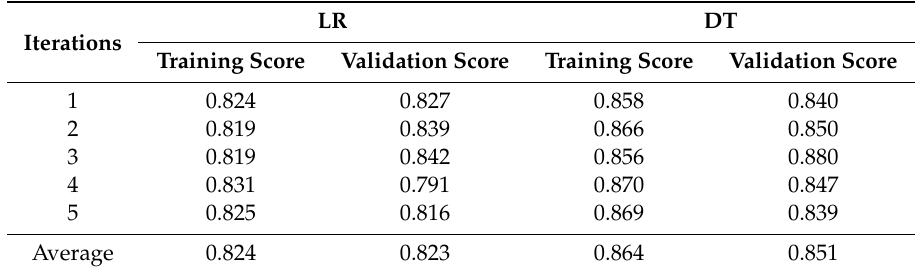
Table 4. Five-fold cross validation score of implemented Logistic Regression (LR) and DT